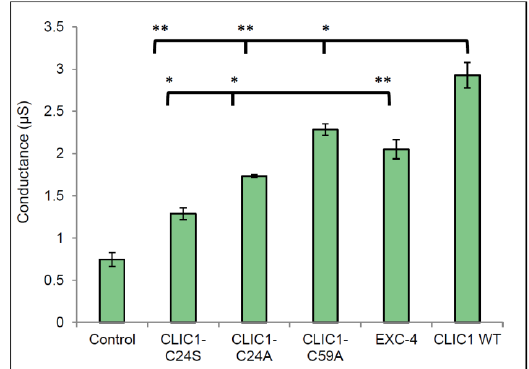
Figure 4. Conductance of CLIC1 mutants and EXC-4 in membranes containing 25 mol % cholesterol. 20 µg of CLIC1-C24A; CLIC1-C24S; CLIC1-C59A; EXC-4 and CLIC1 (WT) proteins in 100